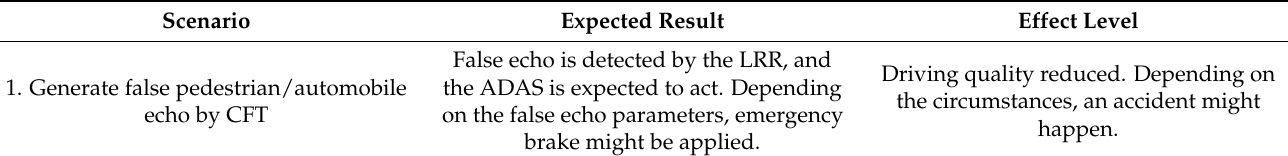
Table 4. Scenario